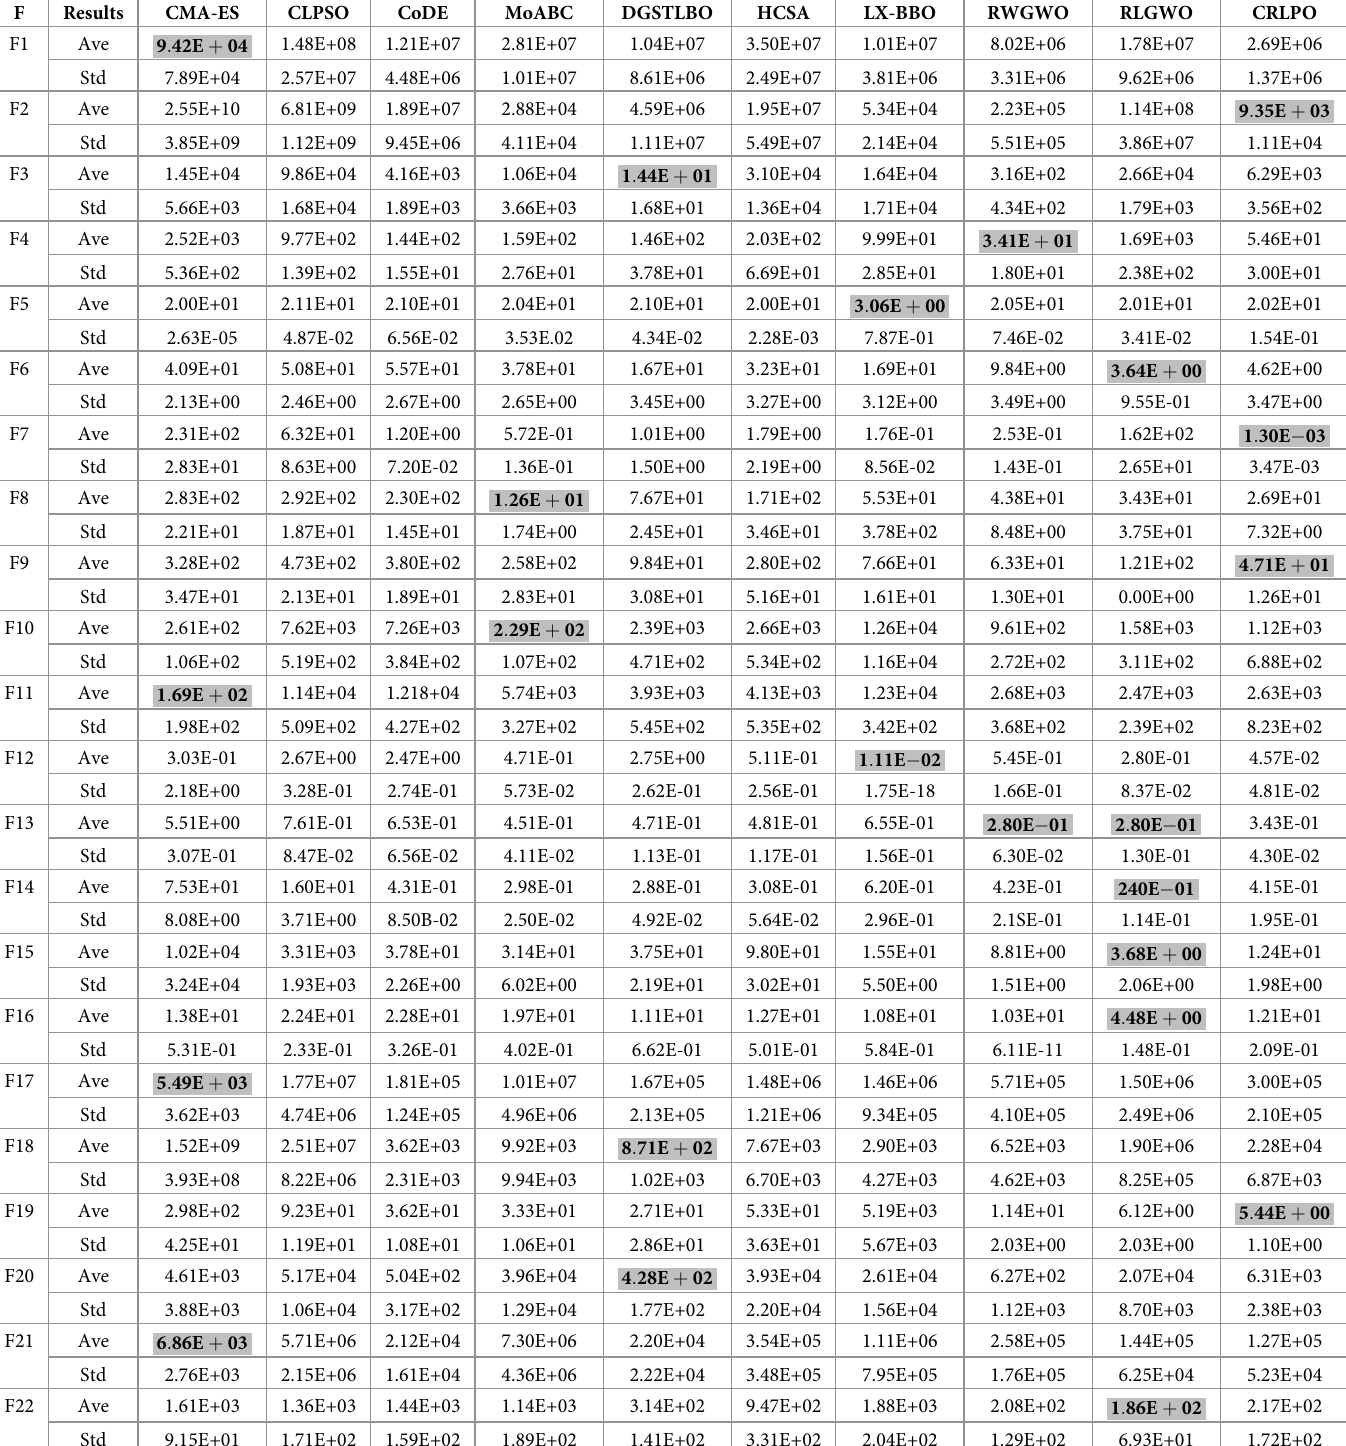
Table 8. Comparison of CRLPO and nine selected algorithms on 30 test functions with 30 dimensions from IEEE CEC